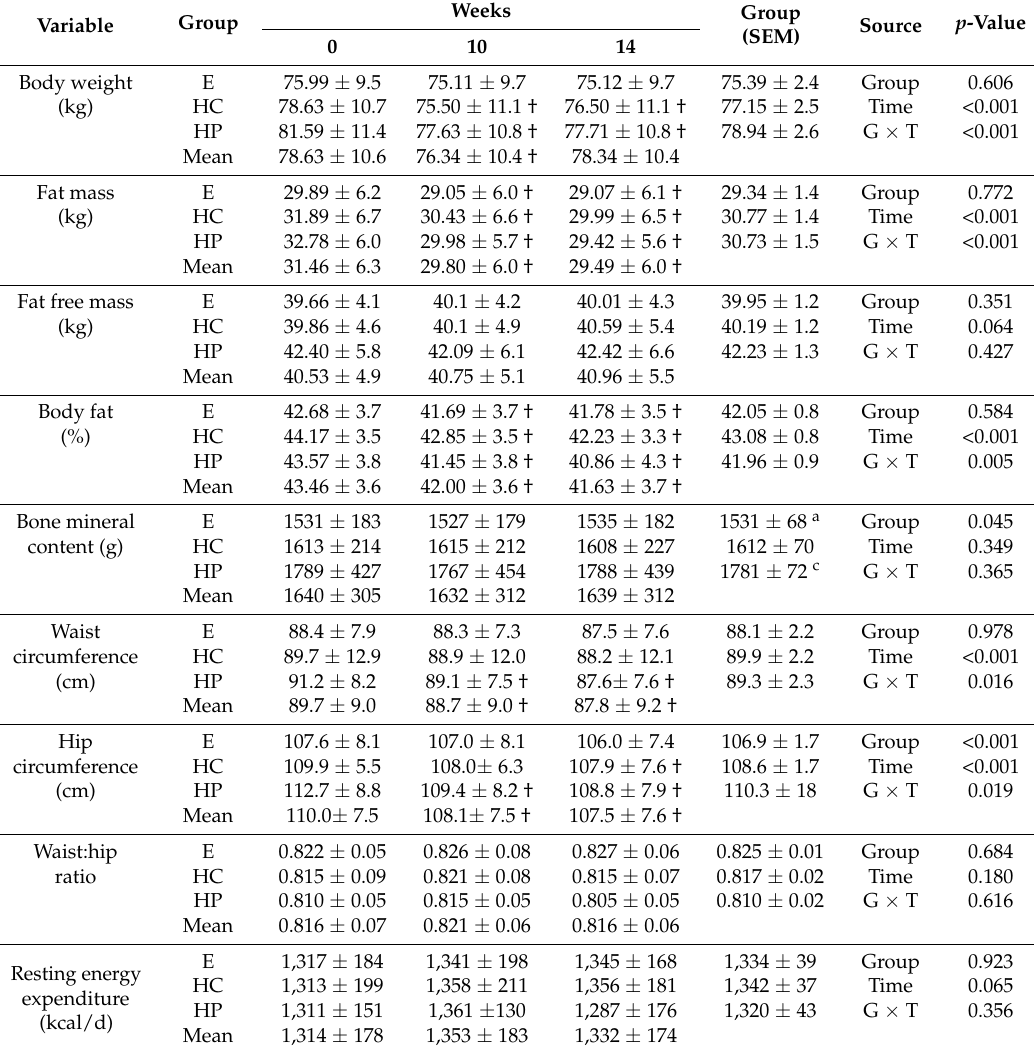
Table 3. Body composition, anthropometric, and resting energy expenditure